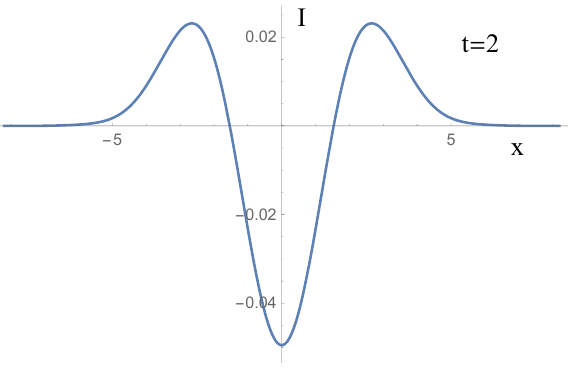
Figure 4. Same as in Figure 3, with t = 2.